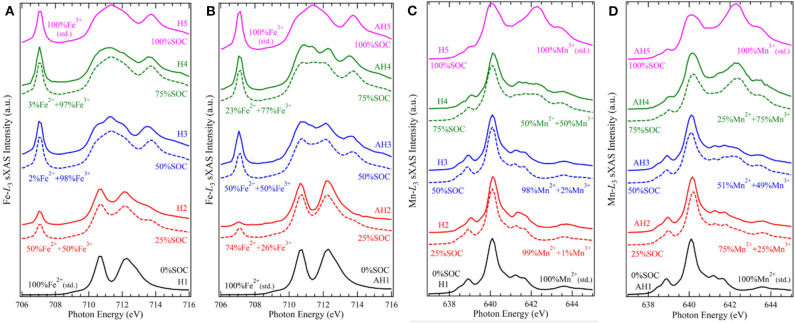
Fe and Mn L3-edge soft X-ray absorption spectroscopy (sXAS) spectra collected on a series electrode samples of NaxMnFe(CN)6·zH2O systems, (A) Fe for hydrated, (B) Fe for anhydrated, (C) Mn for hydrated, and (D) Mn for anhydrated. The calculated values were achieved by linear fitting of reference spectra. Reprinted from Wu et al. (2017) with no permission required from authors.